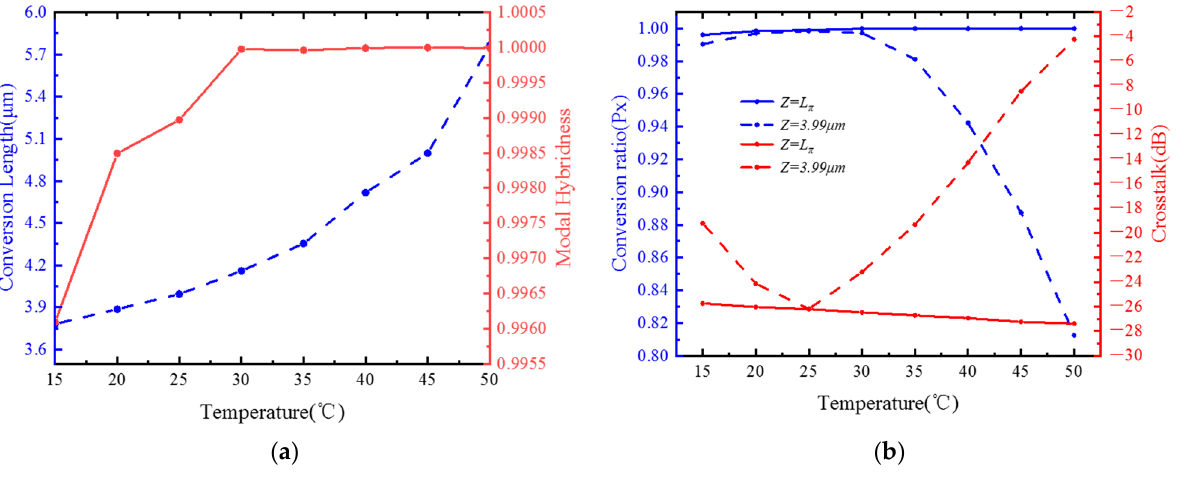
Figure 7. ( a ) Variations of conversion length and modal hybridness with temperature; ( b ) conversion ratio (Px) and CT as functions of temperature at Z = L π and Z = 3.99 μ m.